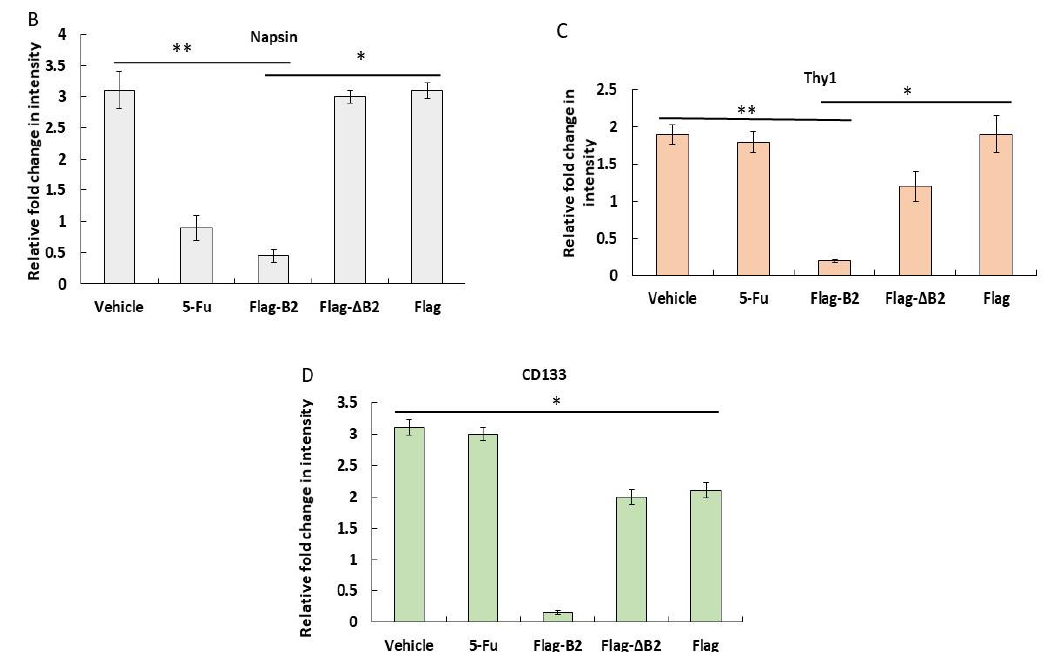
Figure 7. B2-mediated oxidative stress in solid tumors can reduce the expression of tumor markers napsin, Thy1, and CD133 in NOD/SCID mice. ( A ) Solid tumors obtained from the lungs of NOD/SCID mice that underwent treatment with 5-FU (positive control), vehicle (negative control), Flag-B2, Flag, and Flag- ∆ B2 (mutant control) were immunostained with anti-napsin, anti-Thy1, and anti-CD133 antibodies. Scale bar = 100 uM. Quantification of signal intensity of ( B ) napsin, ( C ) Thy1, and ( D ) CD133 (All N = 3). The data are representative of three separate experiments, and the error bars represent the SEMs. * p < 0.05 and ** p < 0.01, as analyzed by one-way ANOVA with Tukey’s multiple comparisons.